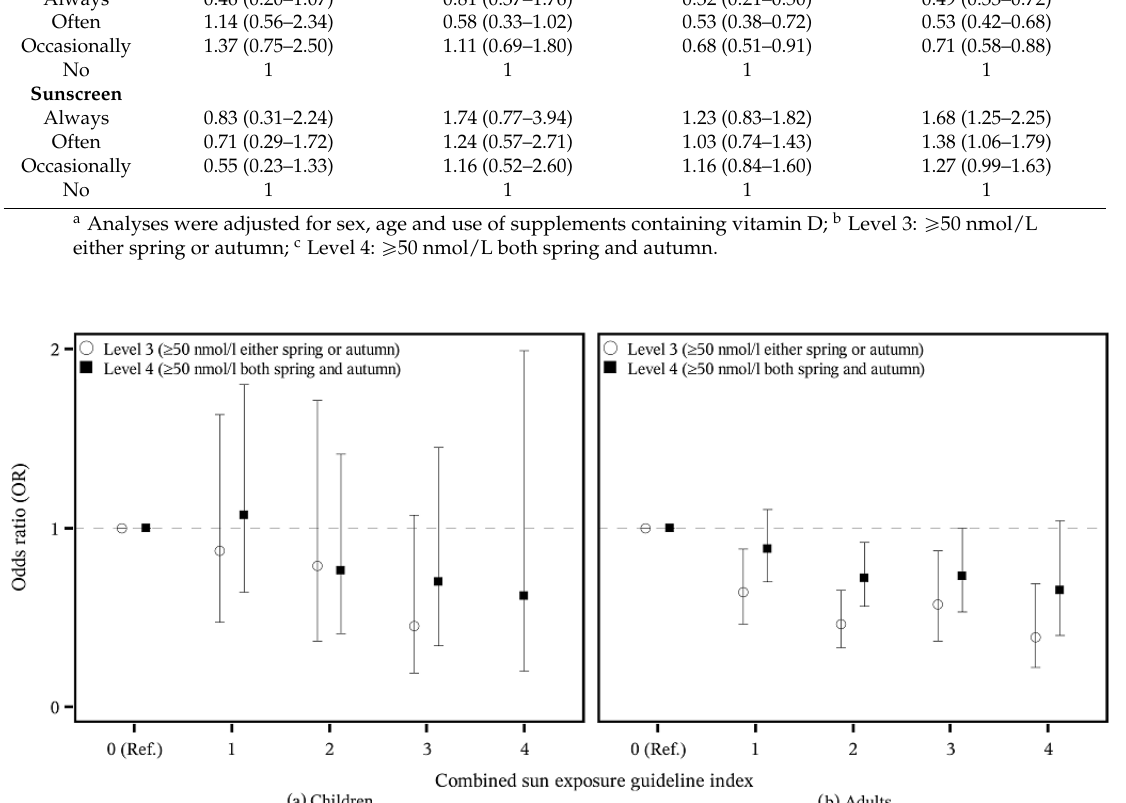
Table 5. Vitamin D concentrations among children (2–15 years) in relation to sun exposure guidelines in the Day care/kindergarten/after school club a .